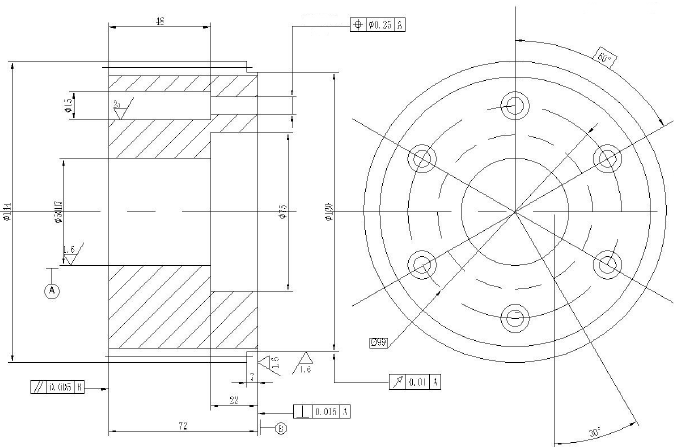
Figure 5. The picture of the